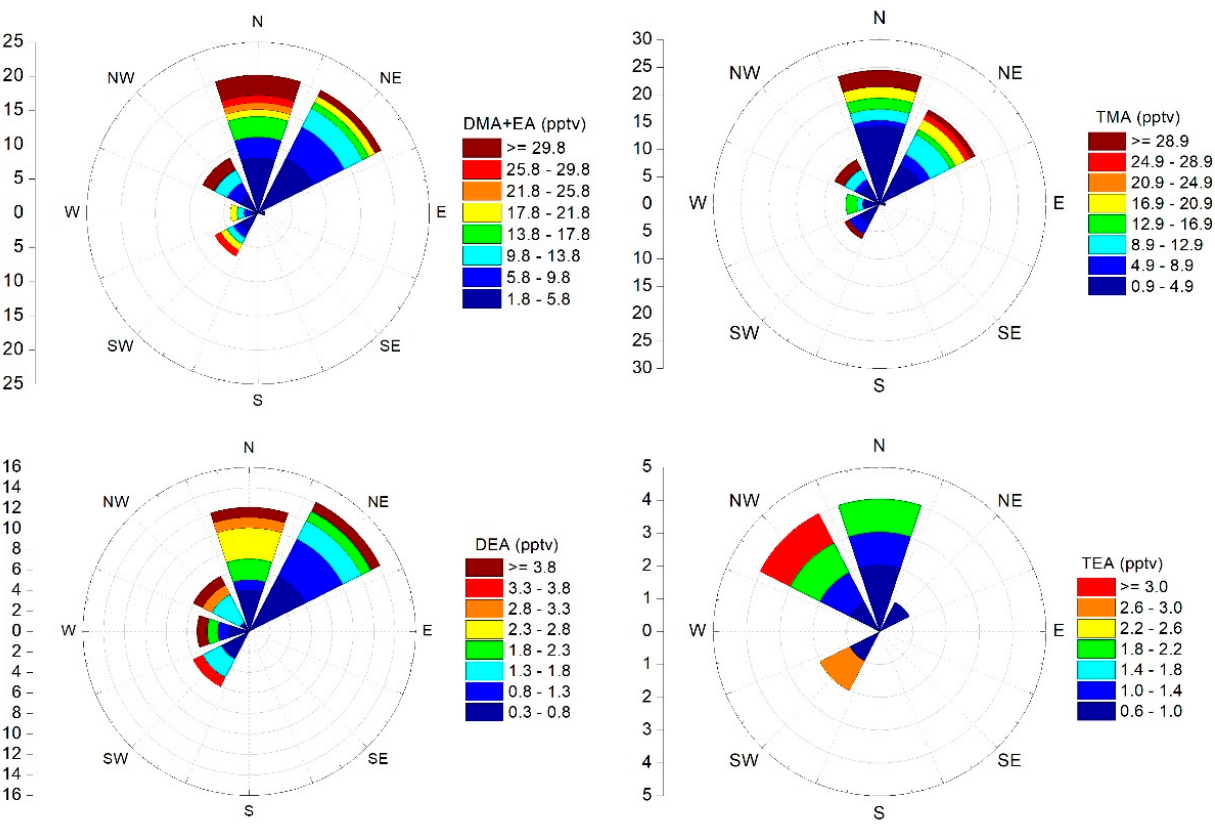
Figure 3. Trajectory analysis for DMA+EA, TMA, DEA and TEA measured on filters collected in air masses with constant origin for all three days of sampling. Y axis shows the number of samples, amine concentrations are in pptv.